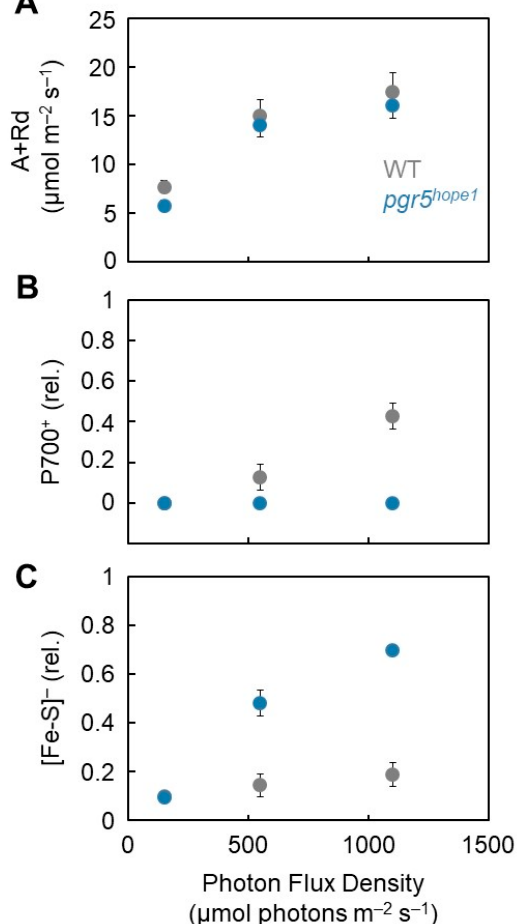
Figure 4. Effect of photon flux density on the gross CO 2 assimilation rate (A + Rd), oxidized P700 (P700 + ), and reduction ratio of Fe/S signals [Fe/S] − in wild-type (WT) and pgr5 hope1 Arabidopsis. ( A ) The net CO 2 assimilation rates were measured simultaneously with P700 + and Fe/S − under atmospheric conditions (40 Pa CO 2 , 21 kPa O 2 ). The dark respiration rates (Rd) were